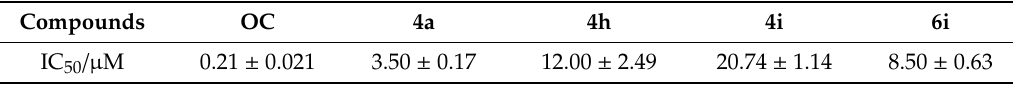
Table 2. The IC 50 values a of several compounds against neuraminidase from H5N1 b subtype.